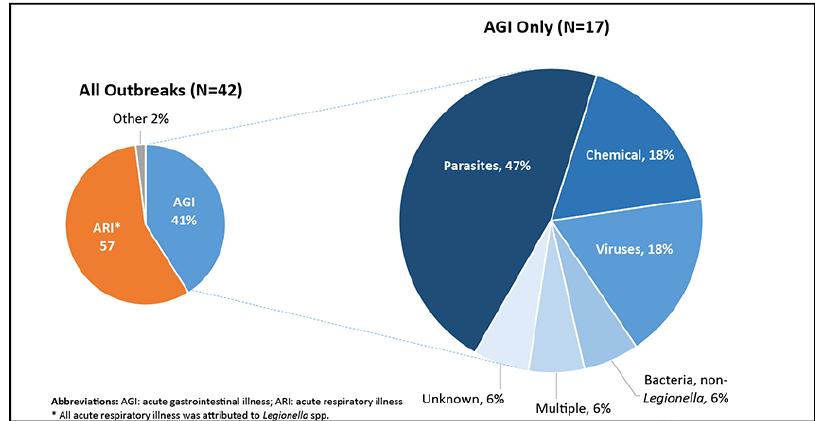
Figure 2. Chief Illness Reported for all Drinking Water Outbreaks, and Etiologies in Outbreaks of Acute Gastrointestinal Illness (AGI), 2013–2014 [6].